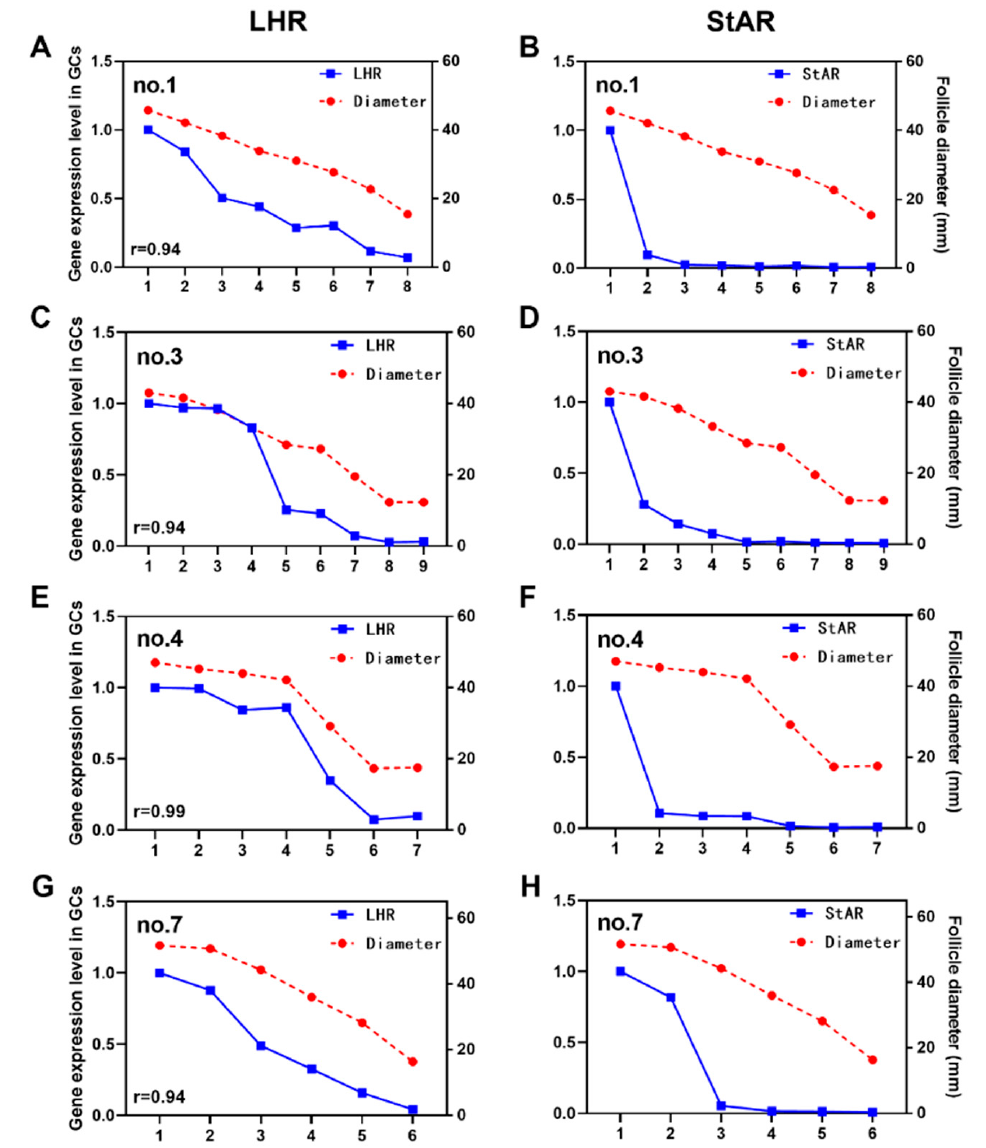
Figure 4. LHR ( A , C , E , G ) and StAR ( B , D , F , H ) expression and follicle diameter in granulosa cells (GCs).